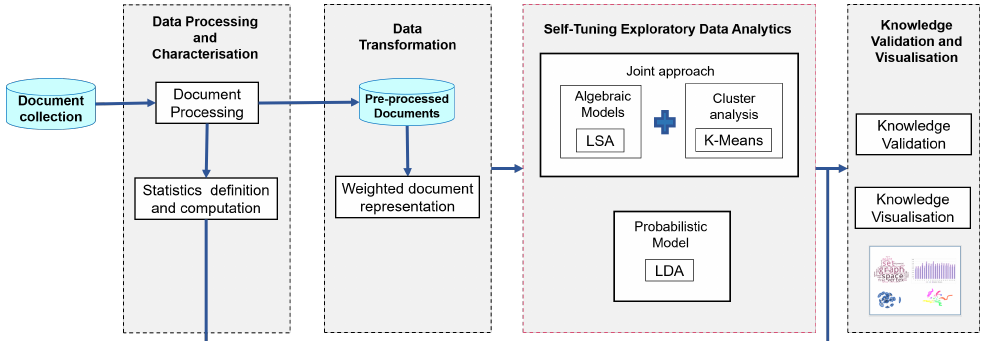
Figure 2. The ESCAPE system